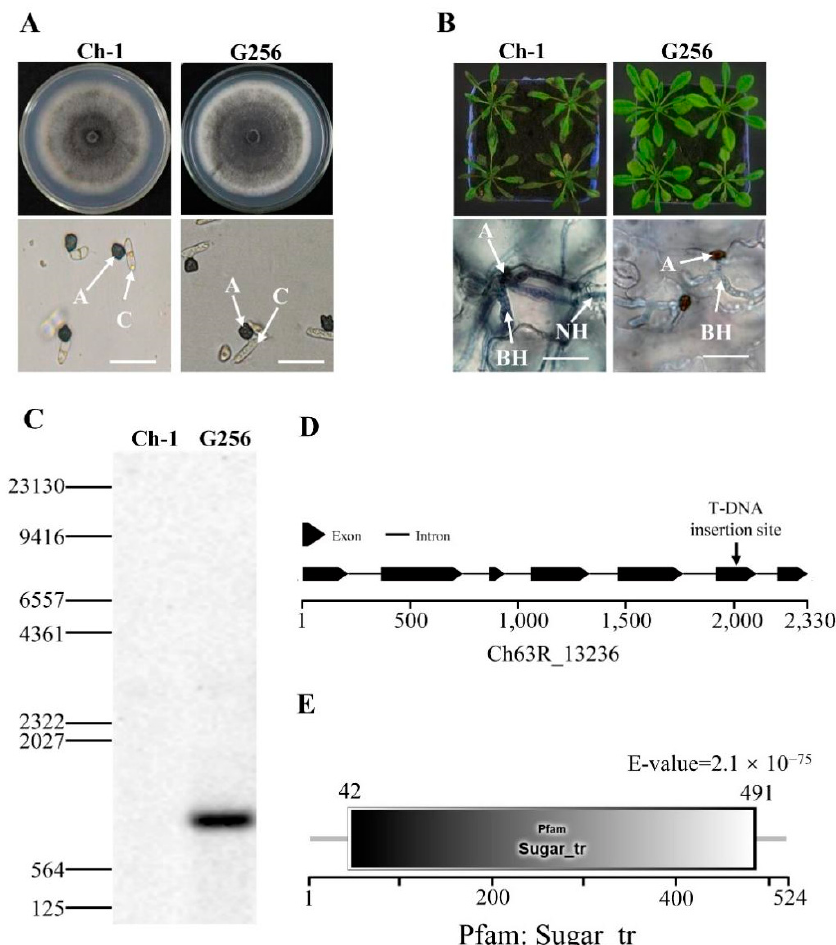
Figure 1. Identification of T-DNA insertional mutant G256 in C. higginsianum . ( A ) Colony morphology and conidial germination of G256. The top pictures show colony morphology of strains cultured for 7 days on PDA in darkness at 25 °C, and the bottom pictures show conidial germination on plastic coverslips at 24 h. A: appressoria; C: conidia; bar = 20 μ m. ( B ) Virulence test of G256. The pictures on the top show the symptoms caused by spraying inoculation of conidia on 6-week Arabidopsis for 4 days; the pictures at the bottom show observation of infection structures under microscope at 48 h post inoculation, A: appressoria; BH: biotrophic hyphae; NH: necrotrophic hyphae. Bar = 20 μ m. ( C ) Analysis of T-DNA copies inserted in G256 by Southern blotting. The DNA probe was designed for hph. ( D ) T-DNA was inserted in exon of hexose transporter coding gene Ch63R_13236. ( E ) Ch63R_13236 encoding protein contained a conserved Sugar_tr domain.